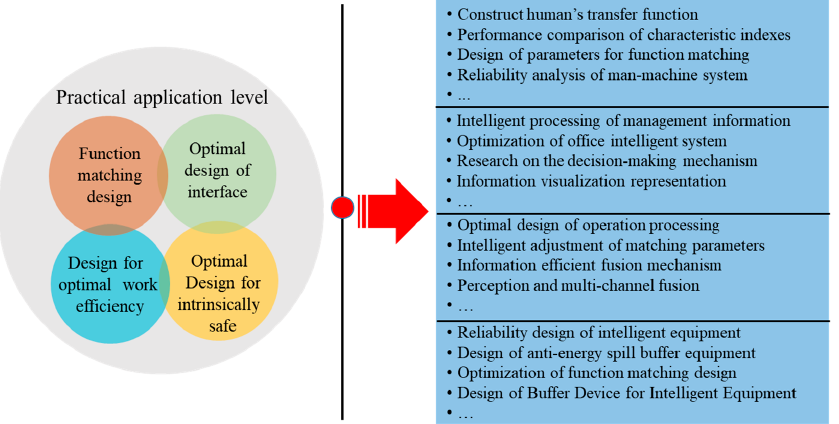
Figure 7. Practical application level of ISE. Practical application level mainly includes function matching design, optimal design of interface, design for optimal work efficiency, and optimal design for intrinsically safe.